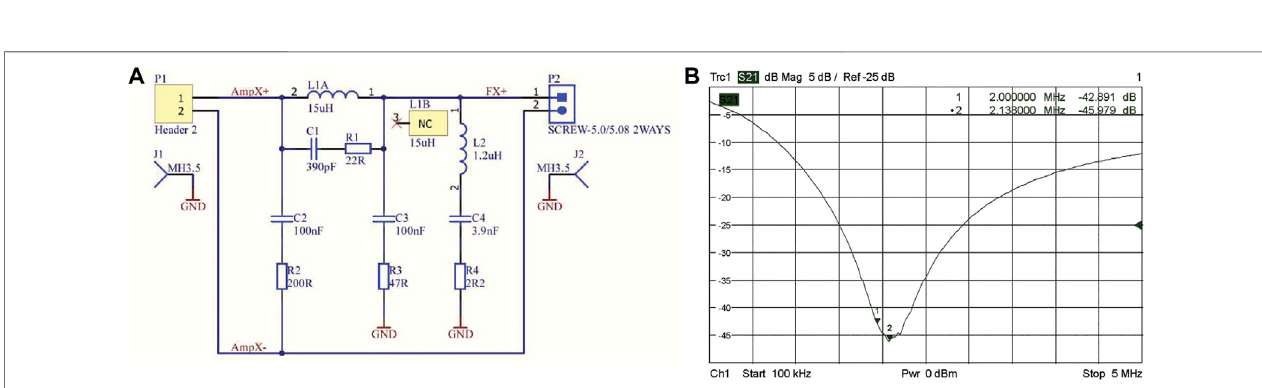
FIGURE 7 | Filter design for gradient ampli fi er output on each channel (A) , S 21 plot of the output fi lters on each channel of the gradient ampli fi er (B) .